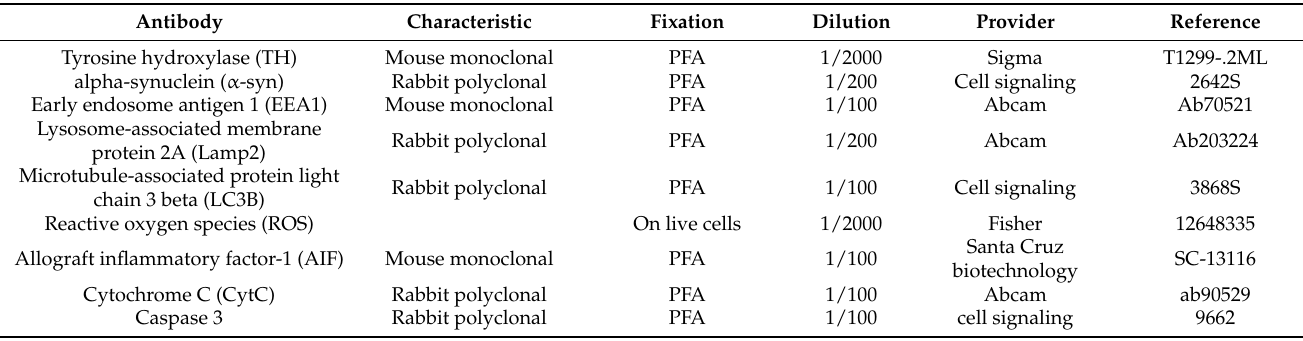
Table 1. List of antibodies used in the present study for